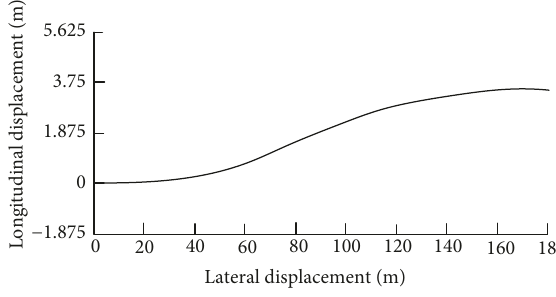
Figure 7: Optimal lane change trajectory.